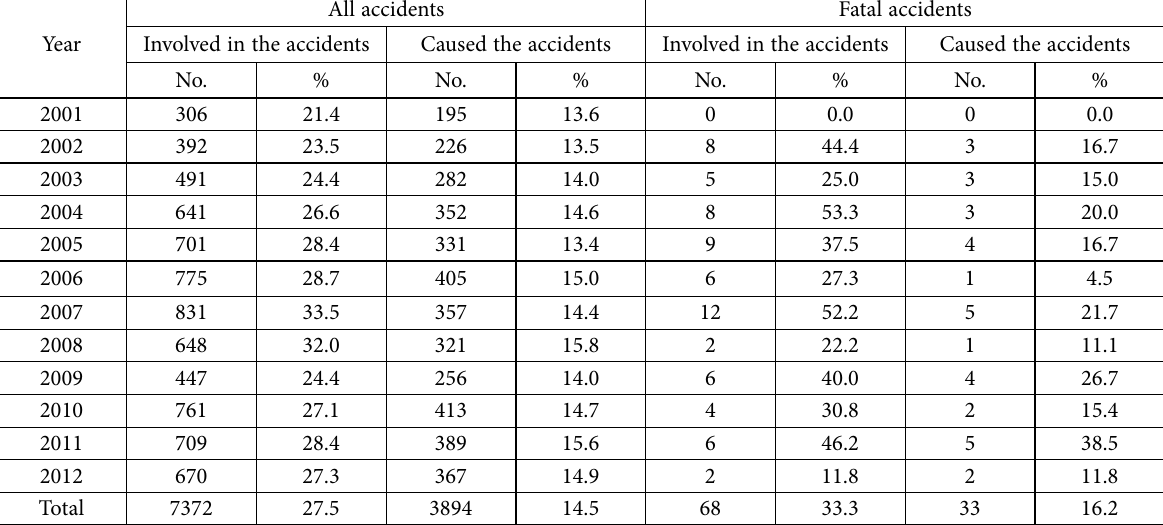
Table 2. The involvement of HGVs in traffic accidents on Slovenian motorways for the period 2001–2012 (source: authors, based on Policija (2015)) All accidents Fatal accidents Year Involved in the accidents Caused the accidents Involved in the accidents Caused the